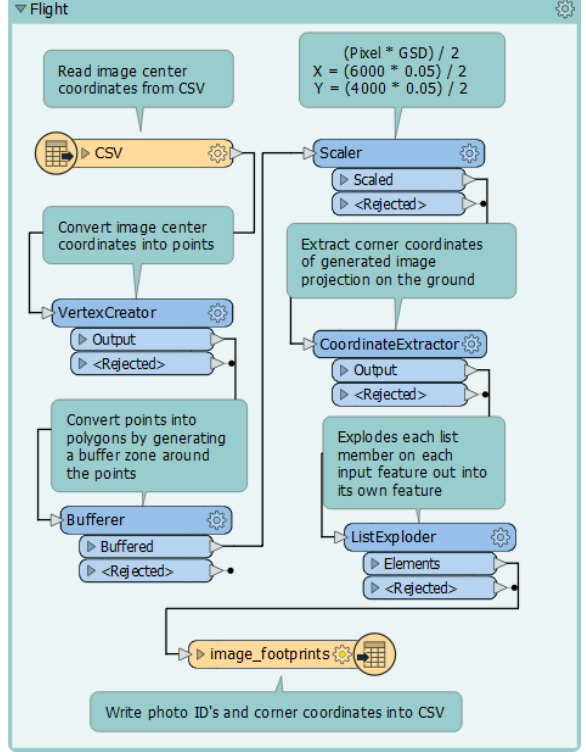
Figure 1 . Generated FME workbench for calculating image footprint corner coordinates on the ground